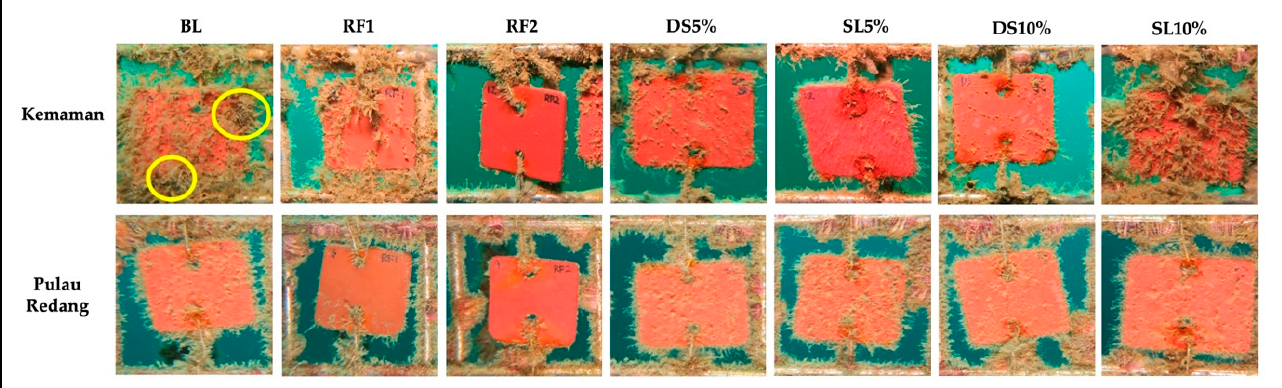
Figure 12. Underwater images of different coated panels in the seawater for five weeks at Kemaman and Pulau Redang. BL: Panel coated with blank paint (control); Panel coated with commercial anti- fouling paint (RF1 and RF2); DS5% and DS10% ( w / v ): Paint with D. setosum crude extract; SL5% and SL10% ( w / v ): Paint with S. lanceolata crude extract. Yellow circles indicate the a tt achment of barnacles on the surface of the blank paint panel.